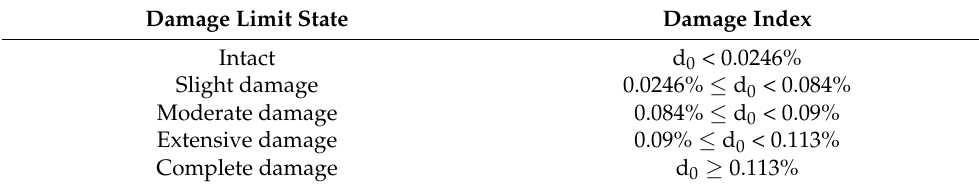
Table 6. Definition of different damage states of the